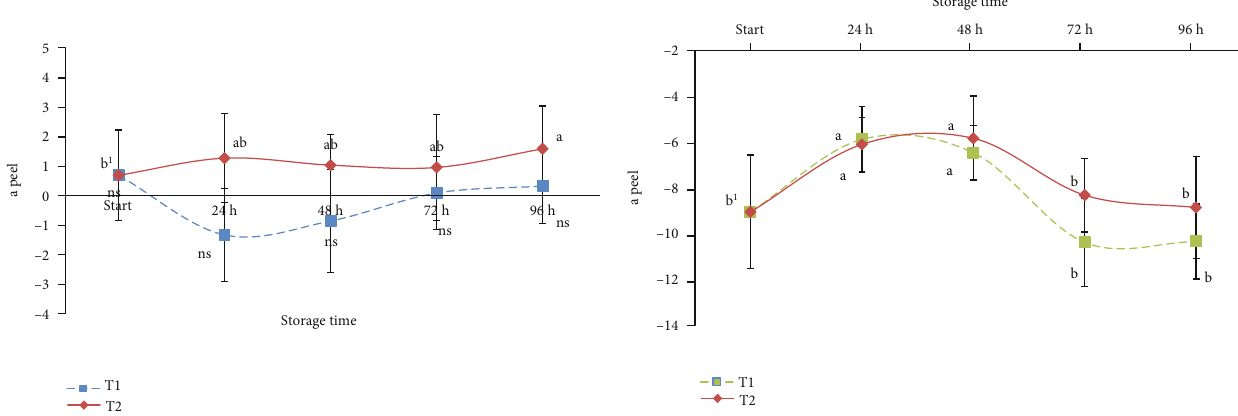
Figure 3: Evolution of greenness (a) colour parameter of stored cv. Hass (peel and pulp). Values followed by di ff erent letters are signi fi cantly di ff erent at P ≤ 0 : 05 (Tukey ’ s post hoc test).